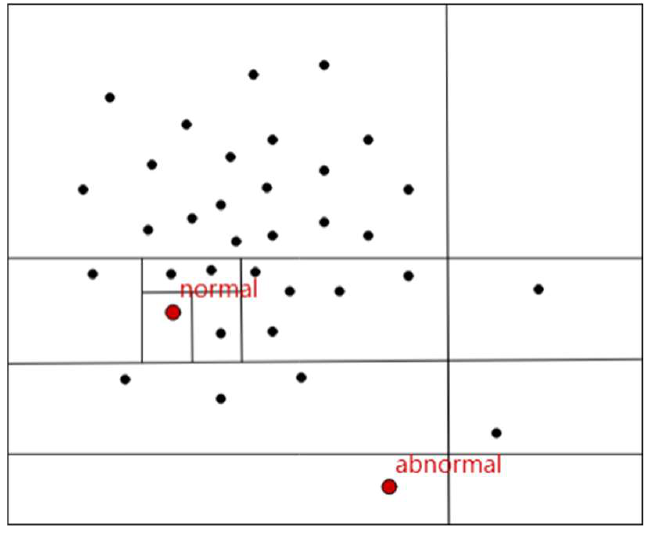
Figure 7. iForest to determine the outlier: characteristics of abnormal points: few and different. In the iForest algorithm, the contamination value is an important hyperparameter that represents the approximate proportion of outliers in the dataset. However, most of the current contamination values need to be specified by continuous commissioning and are not highly automated. For this problem, this paper designs a method to automatically calculate the pollution value by using the centroid data obtained after processing by BIRCH clustering